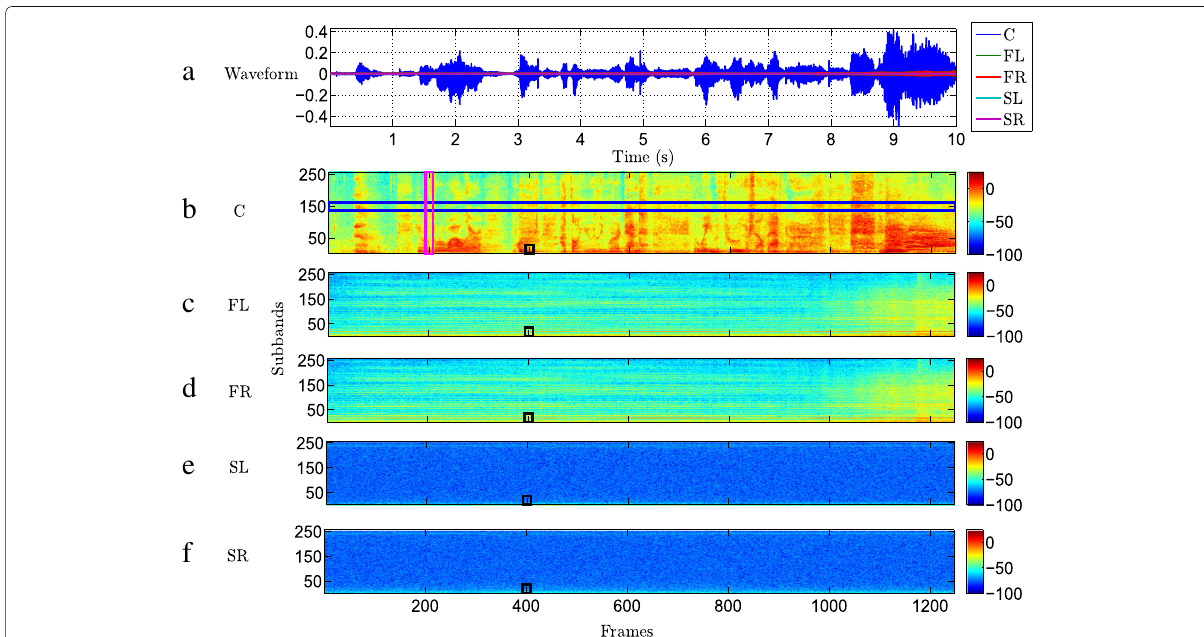
Fig. 4 a Waveform of a 10-s segment from the soundtrack of a five-channel movie signal, with different channels distinguished by color; magnitude spectrogram of ( b ) centre (C), ( c ) front left (FL), ( d ) front right (FR), ( e ) side left (SL), and ( f ) side right (SR) channels, respectively